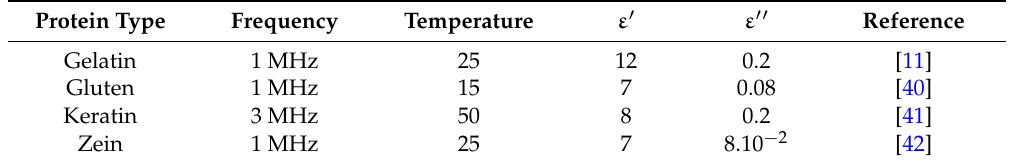
Table 1. Typical values of ε 1 and ε ” for dry natural polymer films (e.g., low relative humidity below 10%). Protein